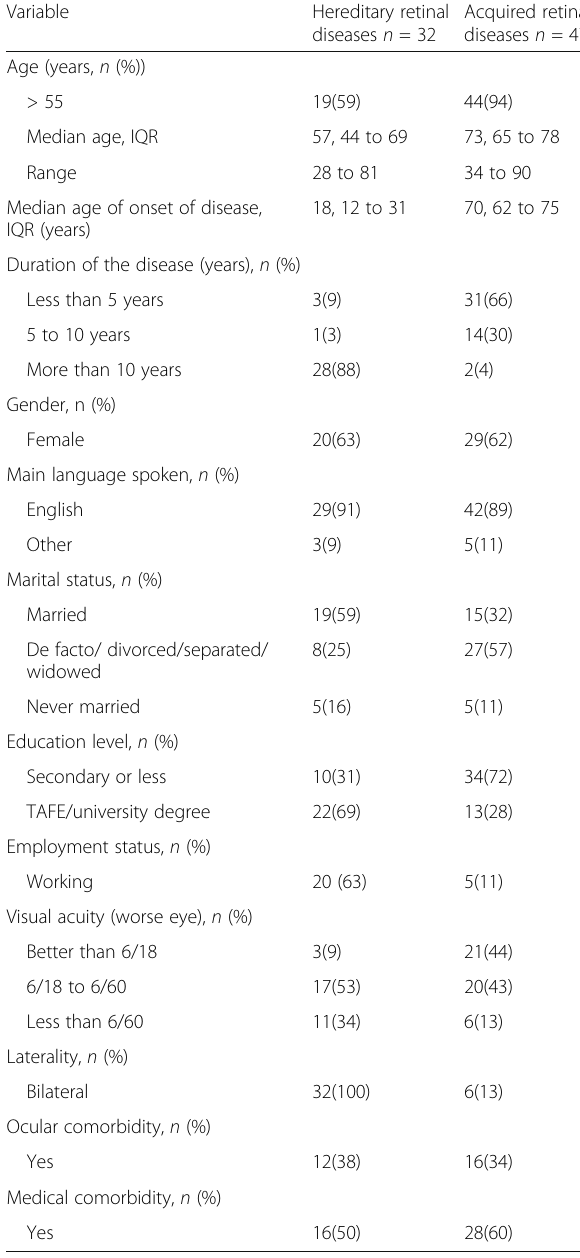
Table 1 Socio-demographic details of the study population Variable Hereditary retinal diseases n =